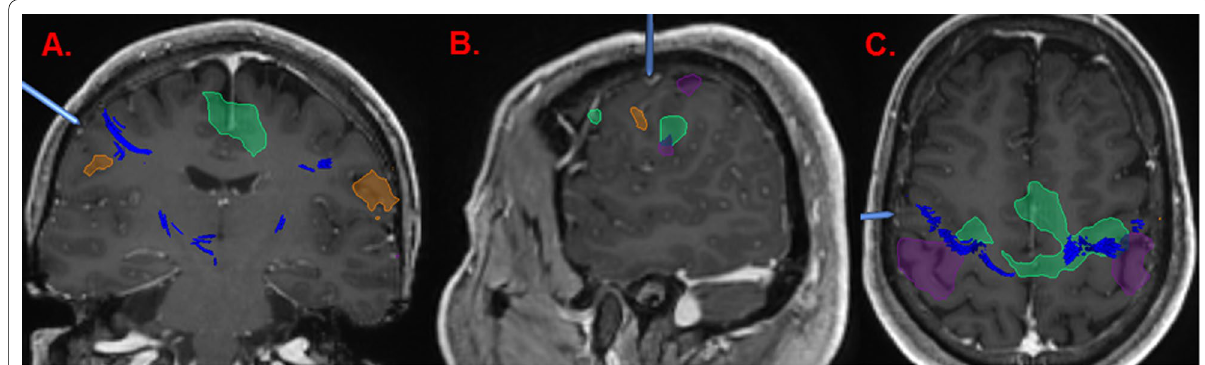
Fig. 1 Preoperative functional MRI. Green